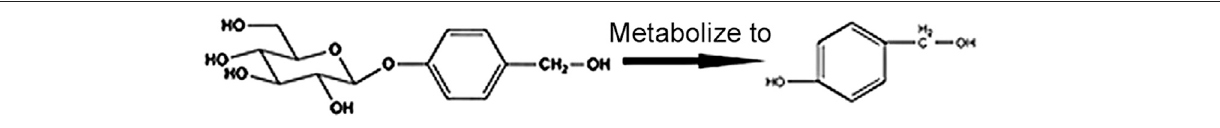
FIGURE 1 | Chemical structure of GAS and HBA as well as metabolization of GAS into HBA in vivo